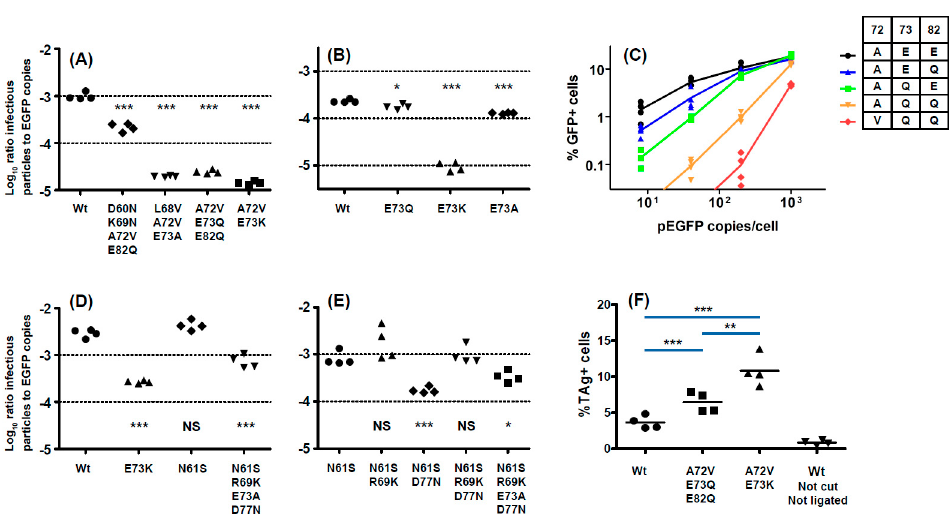
Figure 4. E ff ects of BC-loop mutations on pseudotype and virus infectivity. Infectivity in 293TT cells of PSV with wild-type genotype Ib2 VP1, and VP1 with multiple ( A ) or individual ( B ) BC-loop mutations. Cumulative e ff ect of A72V, E73Q, and E82Q mutations on infectivity of genotype Ib2 PSV in 293TT cells ( C ). Infectivity in 293TT cells of PSV with wild-type genotype IVc2 VP1, and VP1 with multiple BC-loop mutations ( D ). Cumulative e ff ect of R69K, E73A and D77N mutations on infectivity of genotype IVc2 PSV in 293TT cells ( E ). Replication in Vero cells of wild-type BK-MM virus, and mutant viruses incorporating A72V, E73K and A72V, E73Q, E82Q VP1 mutations ( F ). The uncut pBKV 35-1 plasmid was used as a negative control. Significant di ff erences between groups were tested by one-way ANOVA followed by Tukey’s post-hoc test *** p < 0.001; ** p < 0.01, * p < 0.05. All results shown are from one representative experiment of at least two independent experiments.